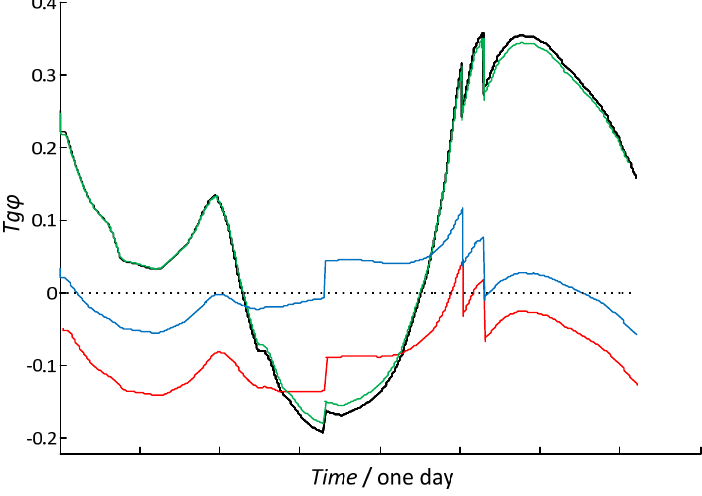
Figure 11. Tg φ for four different generators in the same feeder. Generators have to produce different amounts of reactive power based on their location.